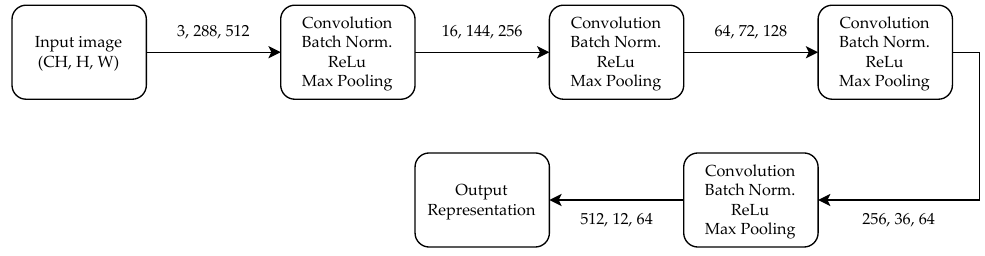
Figure 2. Schematics of the backbone’s